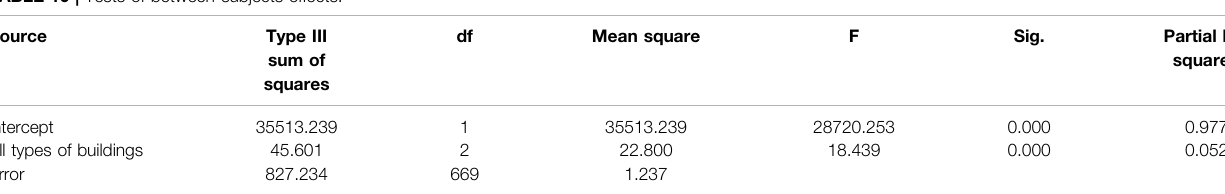
TABLE 10 | Tests of between-subjects effects.